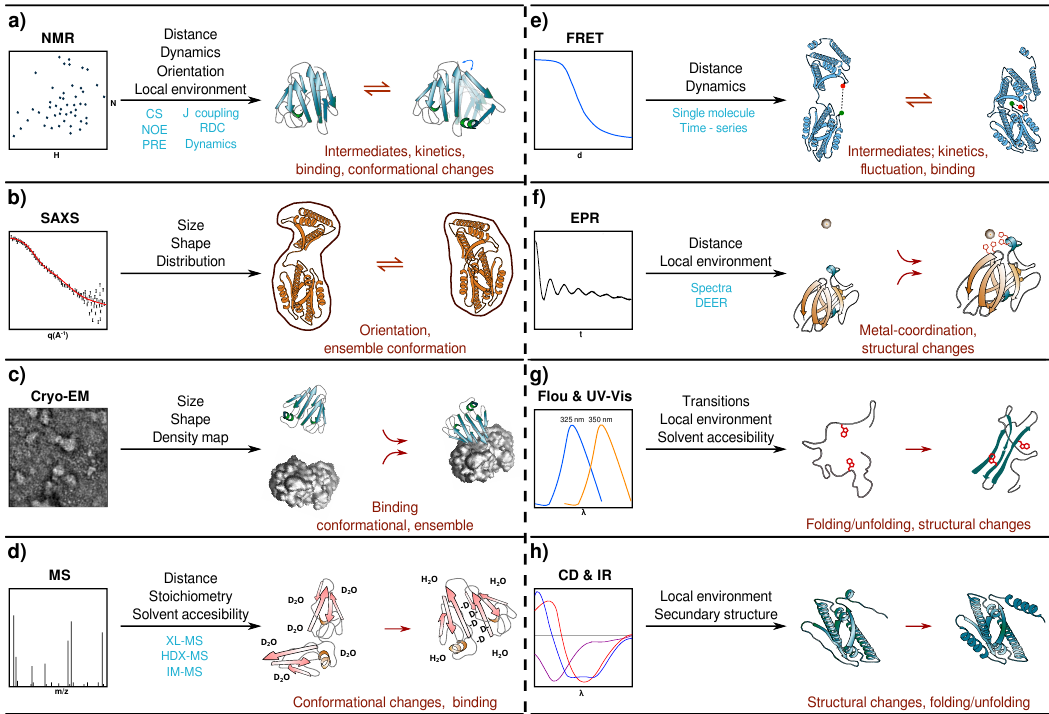
Figure 3. Schematic representation of the di ff erent experimental techniques that are usually combined with computational methods. The biophysical observable and some of the new information processes are listed. ( a ) Nuclear magnetic resonance (NMR). ( b ) Small angle X-ray scattering (SAXS), ( c ) Cryo electron microscopy (Cryo-EM) ( d ) Mass spectrometry (MS), ( e ) Förster resonance energy transfer (FRET), ( f ) Electron paramagnetic resonance (EPR), ( g ) Fluorescence and UV–Vis (Fluo & UV-Vis), ( h ) Circular dichroisms and infrared absorption (CD &